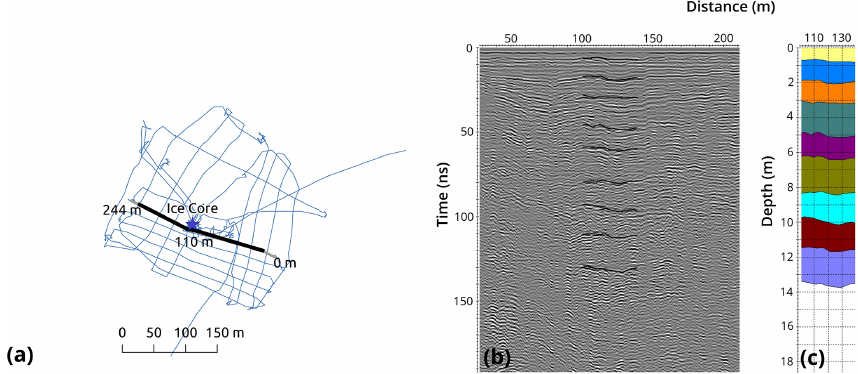
Figure 3. Peter I GPR. (a) Reference map depicts the full track of measurements (blue), the profile (grey), and the section shown in the radargram (black). (b) Section of a radargram taken in an east-westerly direction with layer interpretation and (c) estimated depth of layers.